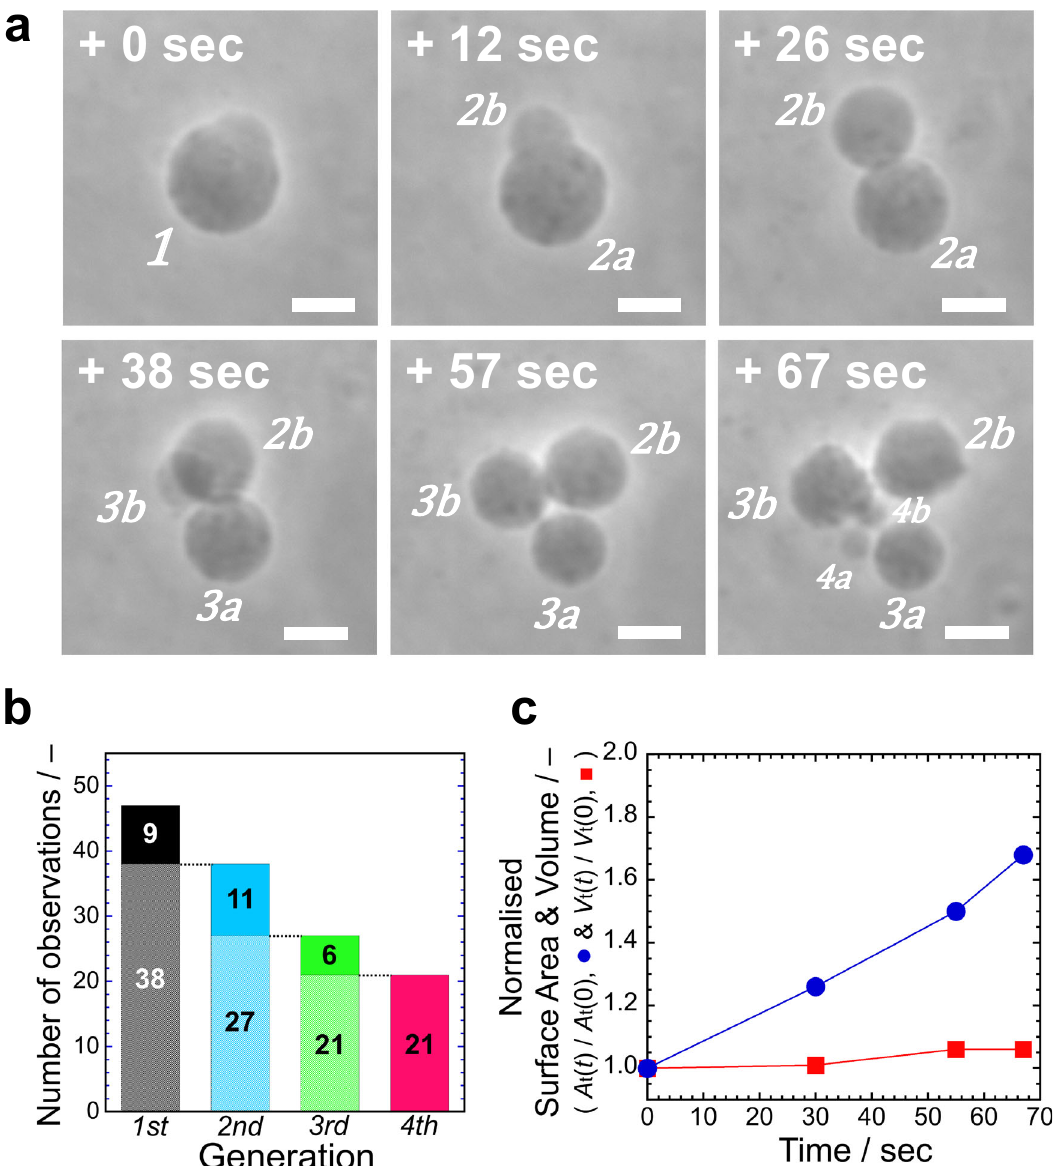
Fig. 4 Membrane growth and division of binary AOT + Chol GUVs coupled with the synthesis of PANI-ES. a Phase contrast light microscopy images of binary AOT + Chol (9/1, mol ratio) GUVs during the polymerisation reaction of aniline, supplied with D-glucose and micelles (AOT micelles and mixed SDBS + Chol micelles) (see Methods ). The mother GUV (#1) produced two daughter GUVs (#2a and #2b), one of the daughter GUVs (#2a) divided into two granddaughter GUVs (#3a and #3b), and one of the granddaughter GUVs (#3b) produced small great-granddaughter GUVs (#4a and #4b). Complete division of the GUVs was con fi rmed by further observation. The elapsed time after starting the micro-injection is indicated in each image. Length of the scale bars: 10 µ m. See also Supplementary Movie 2 . b Statistics about the sustainability of the divisions of binary AOT + Chol (9/1) GUVs. Out of a total of 47 observations, the second-generation vesicles (#2a and #2b in a ) were produced in 38 observations, third-generation vesicles (#3a and #3b in a ) were produced in 27 observations, and fourth-generation vesicles (#4a and #4b in a ) were produced in 21 observations. See also Supplementary Fig. 6a for the size distribution of the GUVs in each generation. c , Changes in normalised total surface area ( A t ( t )/ A t (0), blue circles) and total volume ( V t ( t )/ V t (0), red squares) of all GUVs originating from an initial mother GUV (#1 in a ). The lines between the data points are drawn for guiding the